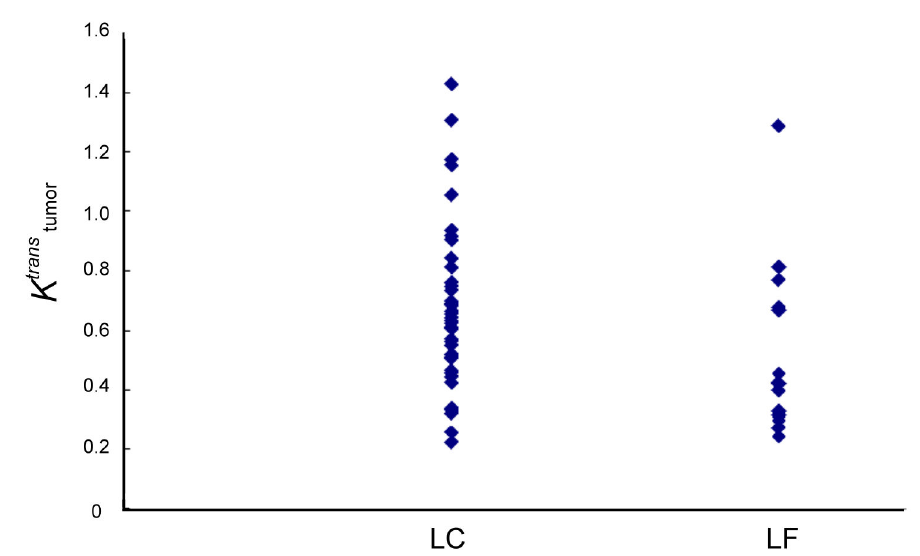
Figure 4. Scatterplots of K trans in the local control (LC, n = 41) and local failure (LR, n=17 ) groups.